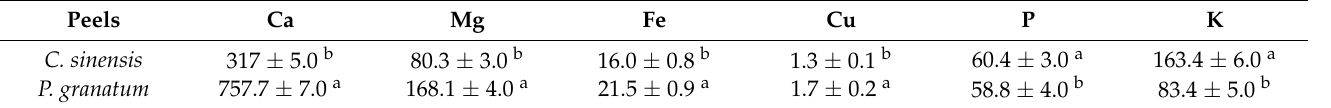
Table 3. Mineral composition of P. granatum and C. sinensis L. peels (mg/100 g DW). Peels